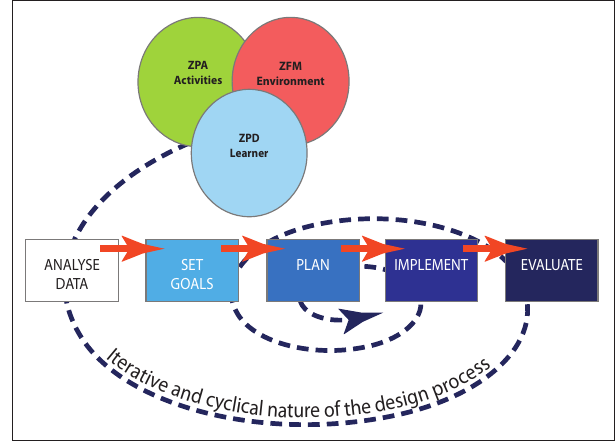
FIGURE 2: Zone theory